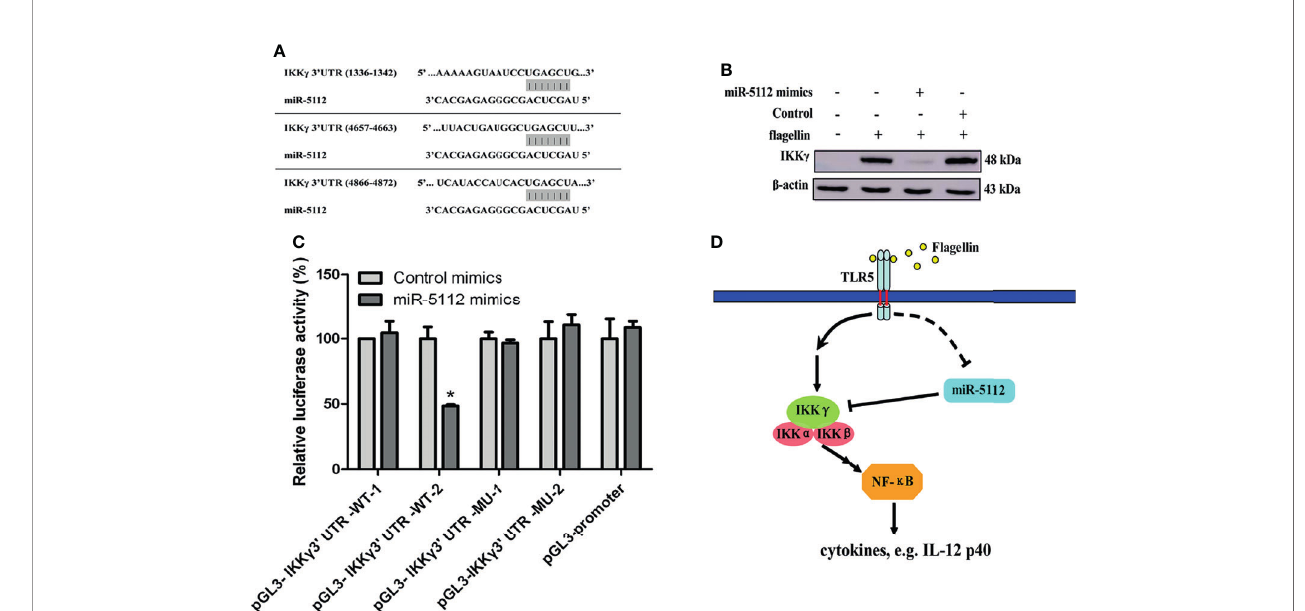
FIGURE 4 | miR-5112 directly targets the IKK g mRNA 3 ’ UTR. (A) Potential target sites of miR-5112 in IKK g mRNA 3 ’ UTR are shown. The binding sites of miR- 5112 were predicted by TargetScan. (B) BMDCs were transfected with miR-5112 mimics and control mimics (30 nM). After 24 h, the cells were stimulated with fl agellin. The IKK g protein expression was detected by Western blotting. b -actin served as a loading control. (C) HEK293T cells were cotransfected with wild-type IKK g 3 ’ UTR reporters (pGL3-IKK g 3 ’ UTR-WT-1, 2) or the indicated mutants (pGL3-IKK g 3 ’ UTR-MU-1, 2) and pTK-RL plasmid, together with miR-5112 mimics or control mimics. After 24 h, fi re fl y luciferase activity was measured and normalized to Renilla luciferase activity. The data shown represent the means ± SEM from 3 independent experiments. * P < 0.05. (D) A proposed working model depicting a potential miR-5112 regulatory mechanism for in fl ammatory production in fl